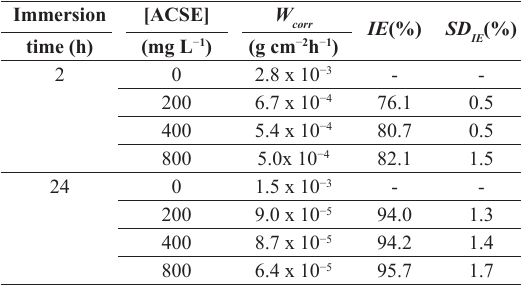
Table 1. Weight loss assays for mild steel in 1 mol L −1 HCl varying ACSE concentration and immersion time. Immersion